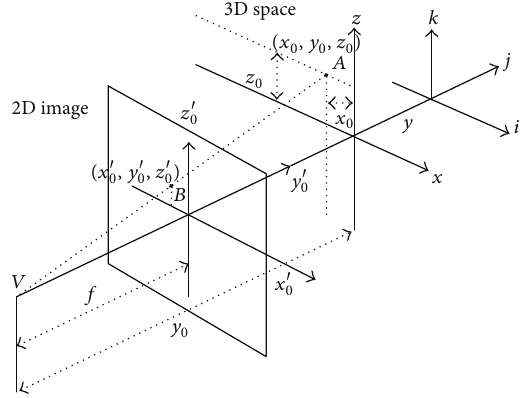
Figure 2: A point in 3D space mapped into 2D image.